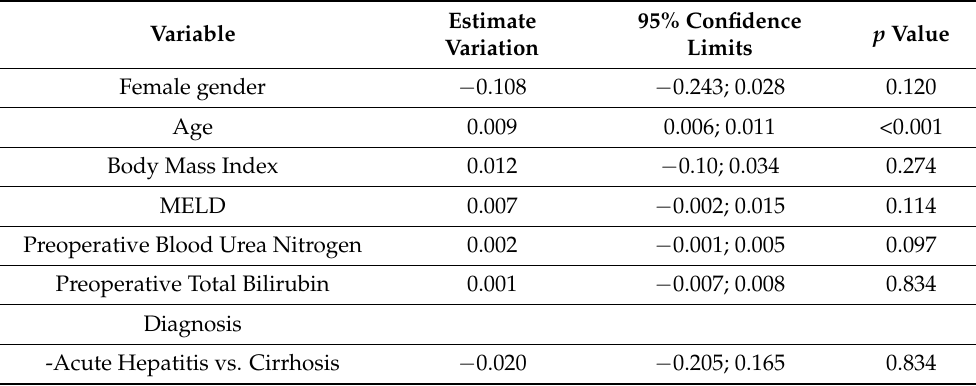
Table 4. Factors associated with changes in creatinine over follow-up. Estimate, confidence limits, and p -values are shown. MELD: Model for End-stage Liver Disease; PRBC: packed red blood cells; CRRT: continuous renal replacement therapy.